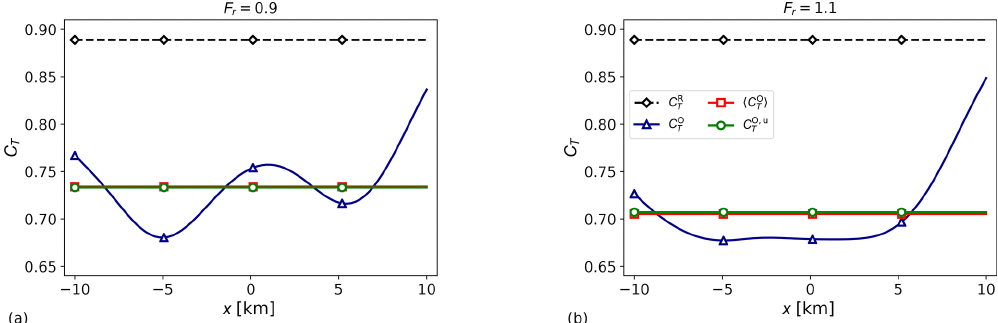
(cid:105) ) T profiles are taken T